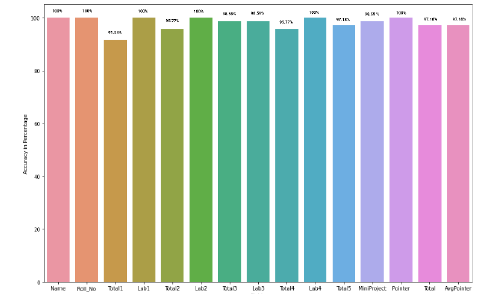
Figure 8. Accuracy Of